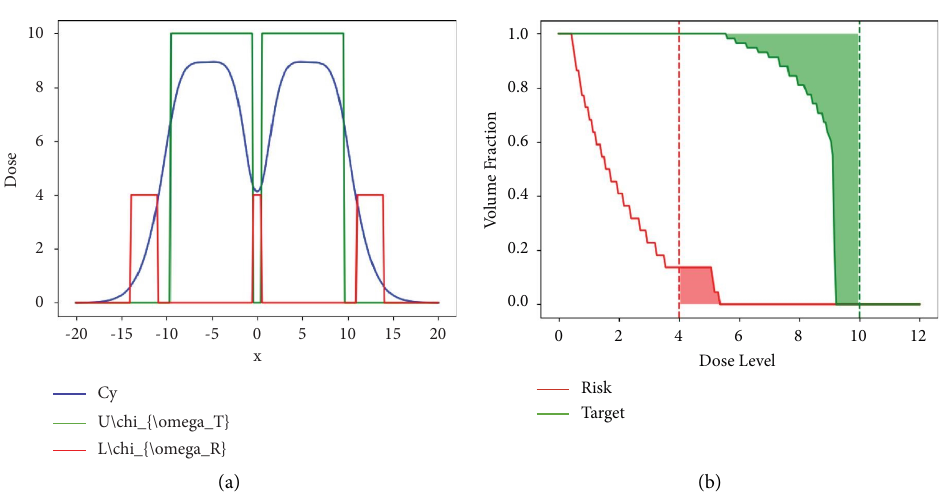
Figure 1: Dose information for dose-constrained equation (2). (a) Final dose C histogram for risk w R and target region w T